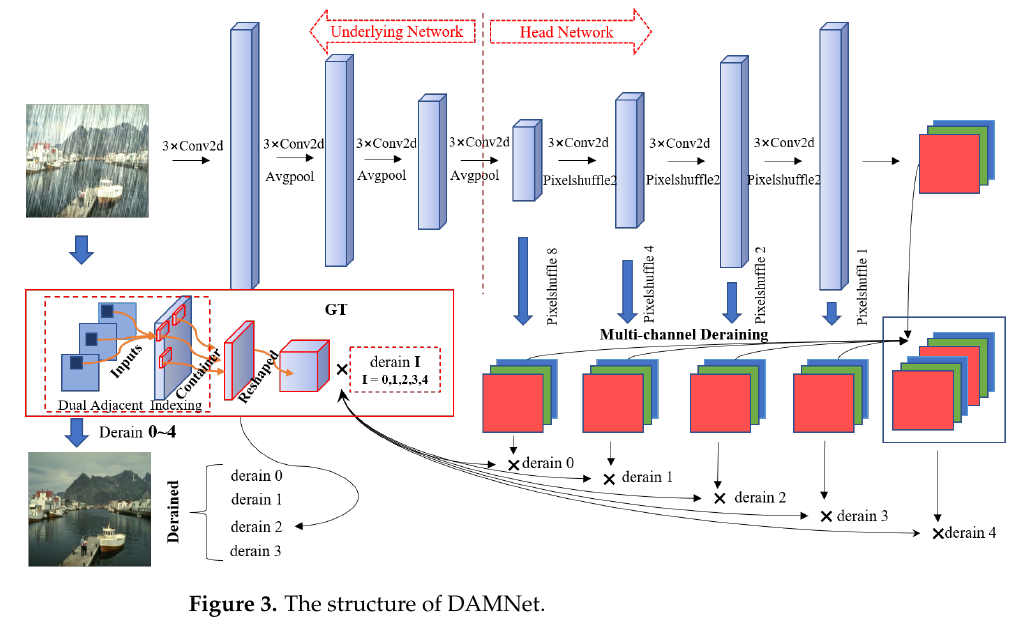
Figure 3. The structure of DAMNet.